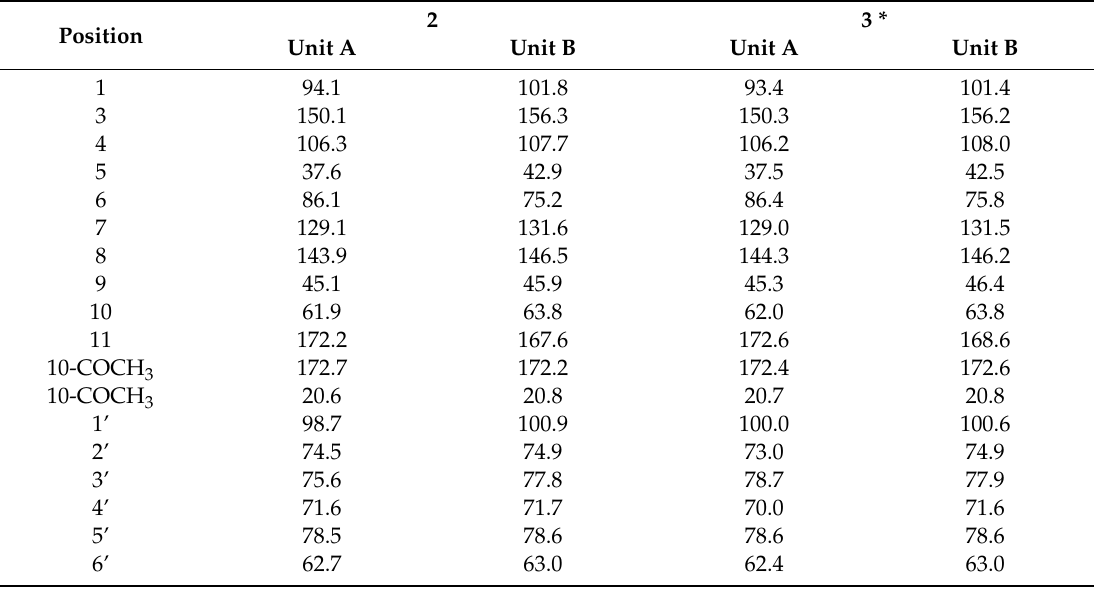
Table 3. 13 C-NMR spectroscopic data for 2 and 3 (125, 175*) MHz, CD 3 OD, δ in